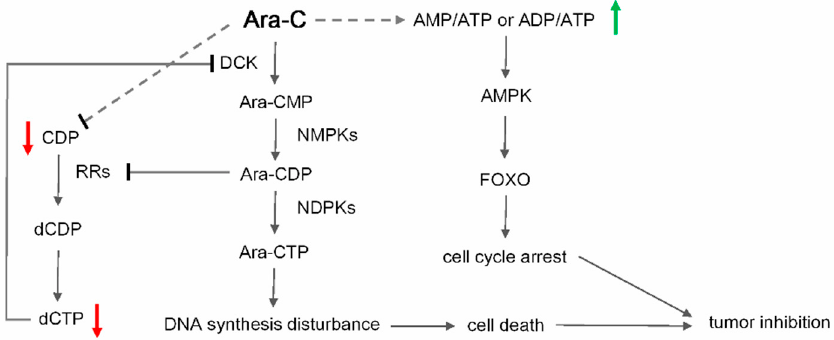
Figure 5. Hypothetic scheme of the antitumor mechanism of high-dose Ara-C.